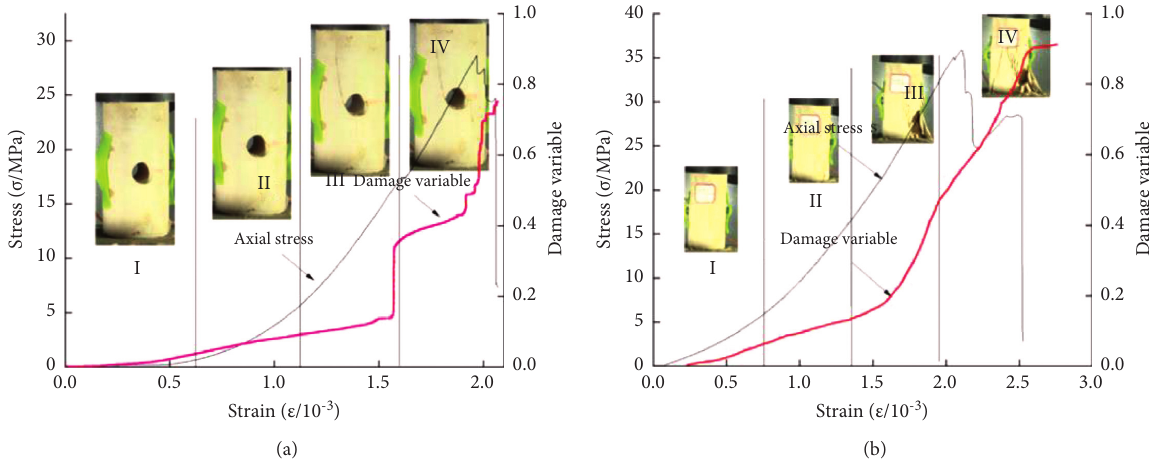
Figure 12: Damage-stress-strain relationship of rock samples with Φ 15mm hole at different positions. (a) Damage-stress-strain rela- tionship of rock D15. (b) Damage-stress-strain relationship of rock